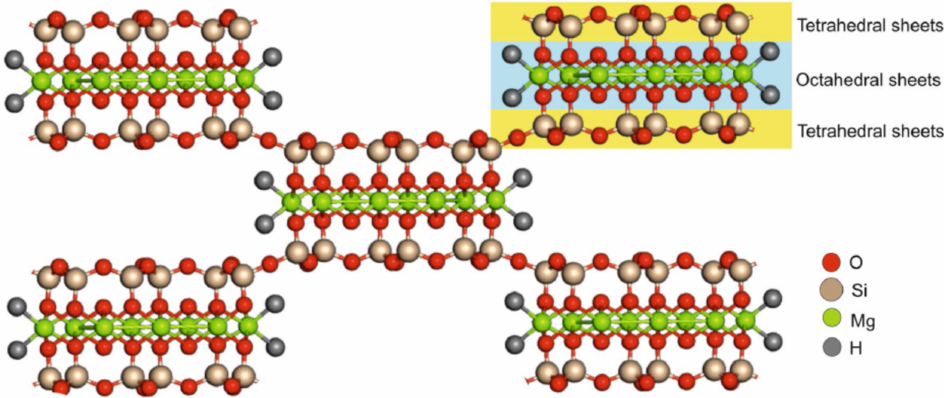
Figure 1. Structure of sepiolite clay. Reprinted/adapted with permission from Ref.